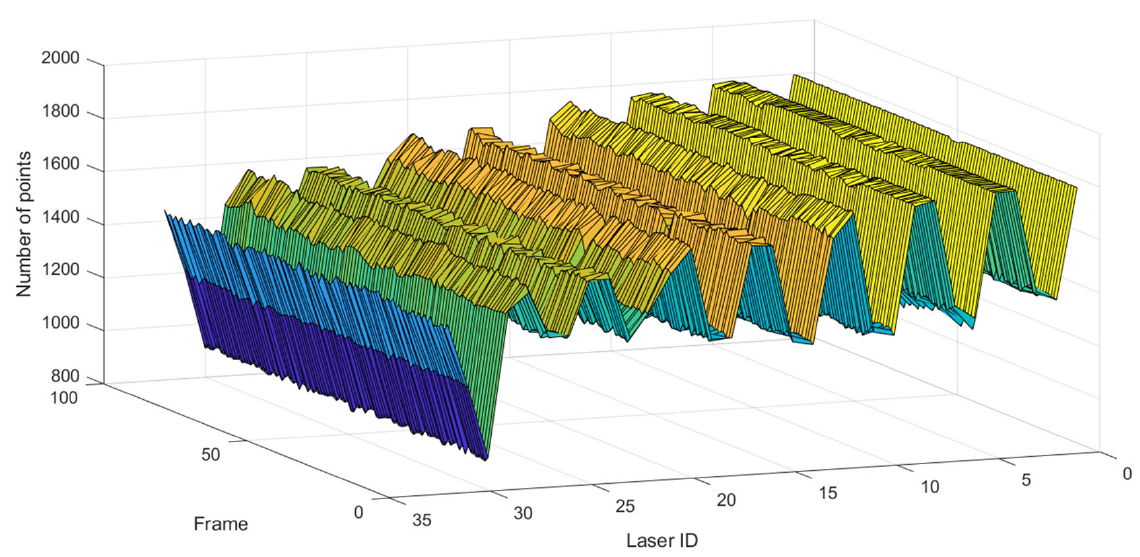
Figure 13. Foreground and background point-cloud data in a frame. Some lasers with the same laser ID are emitted upward, and the LiDAR do not receive echoes, which results in fewer point clouds being collected.